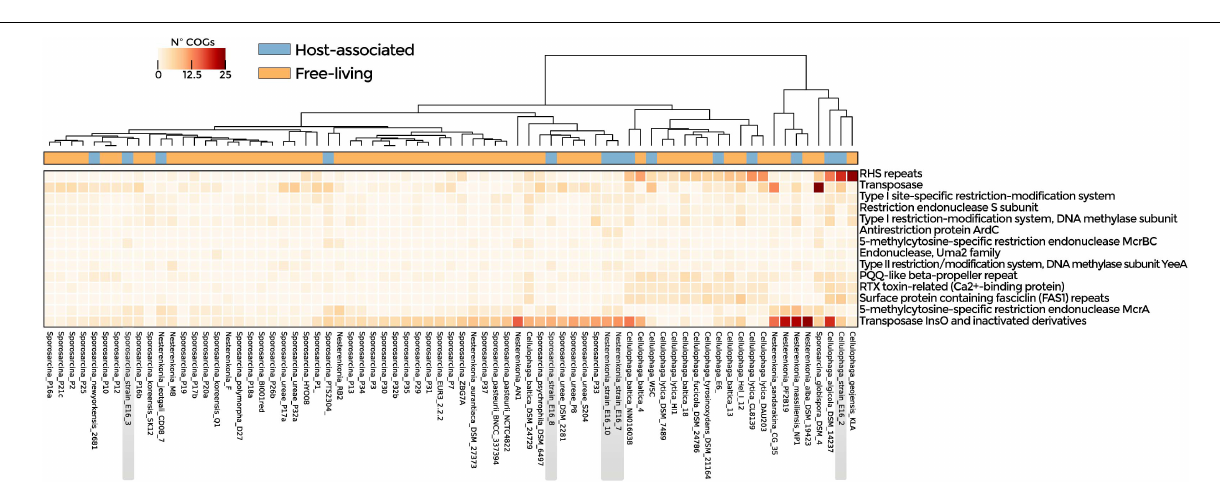
FIGURE 3 | Symbiotic lifestyle functions detected in the genomes of Nesterenkonia , Sporosarcina , and Cellulophaga . COGs related to CRISPR, R-M, and T-A systems, transposases, and ELPs are shown. Heatmap represents the abundance of statistically significant COGs in host-associated and free-living genomes ( p -value <